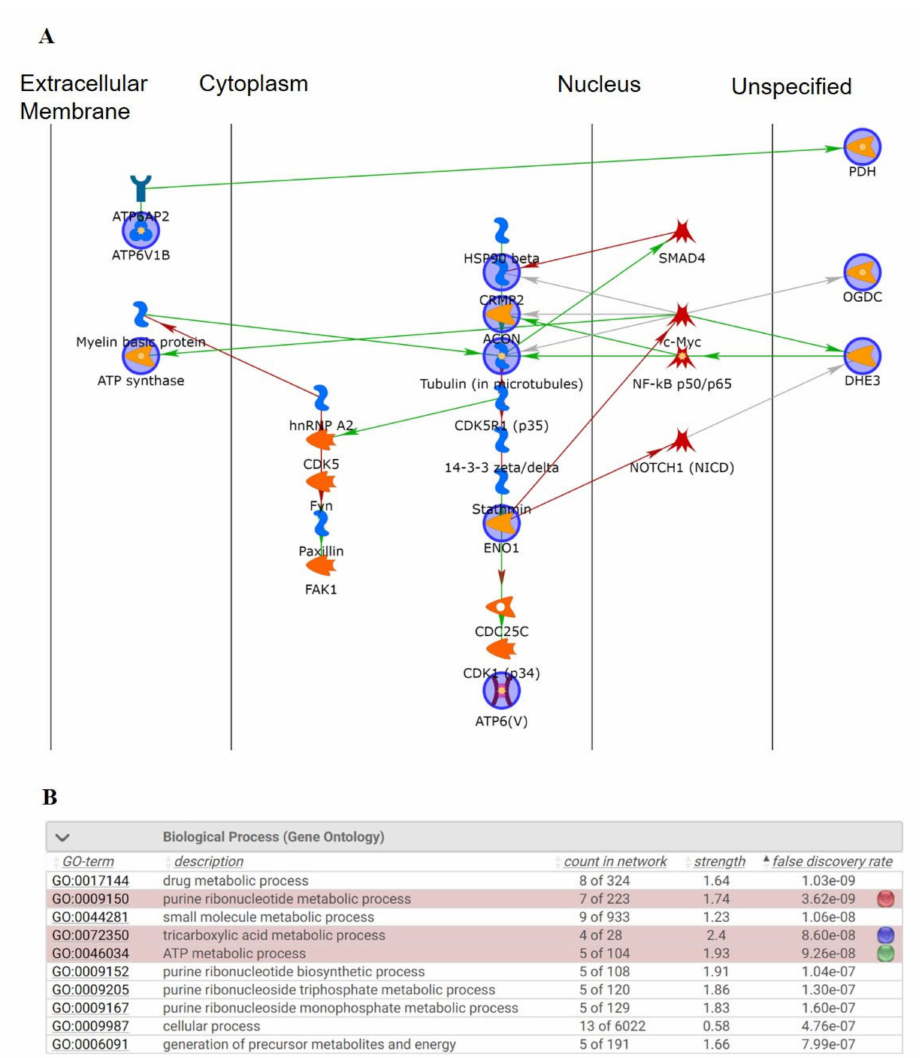
Figure 8. ( A ) Biological network analyses of the differentially expressed proteins using MetaCore™ mapping tools. The nodes represent proteins and the lines between the nodes indicate direct protein– protein interactions. The various proteins on this map are indicated by different symbols representing the functional class of the proteins. ( B ) The top-ranked pathways from the GeneGo MetaCore™ pathway analysis. The pathways were ranked according to the p values. Color nodes: query proteins and first shell of